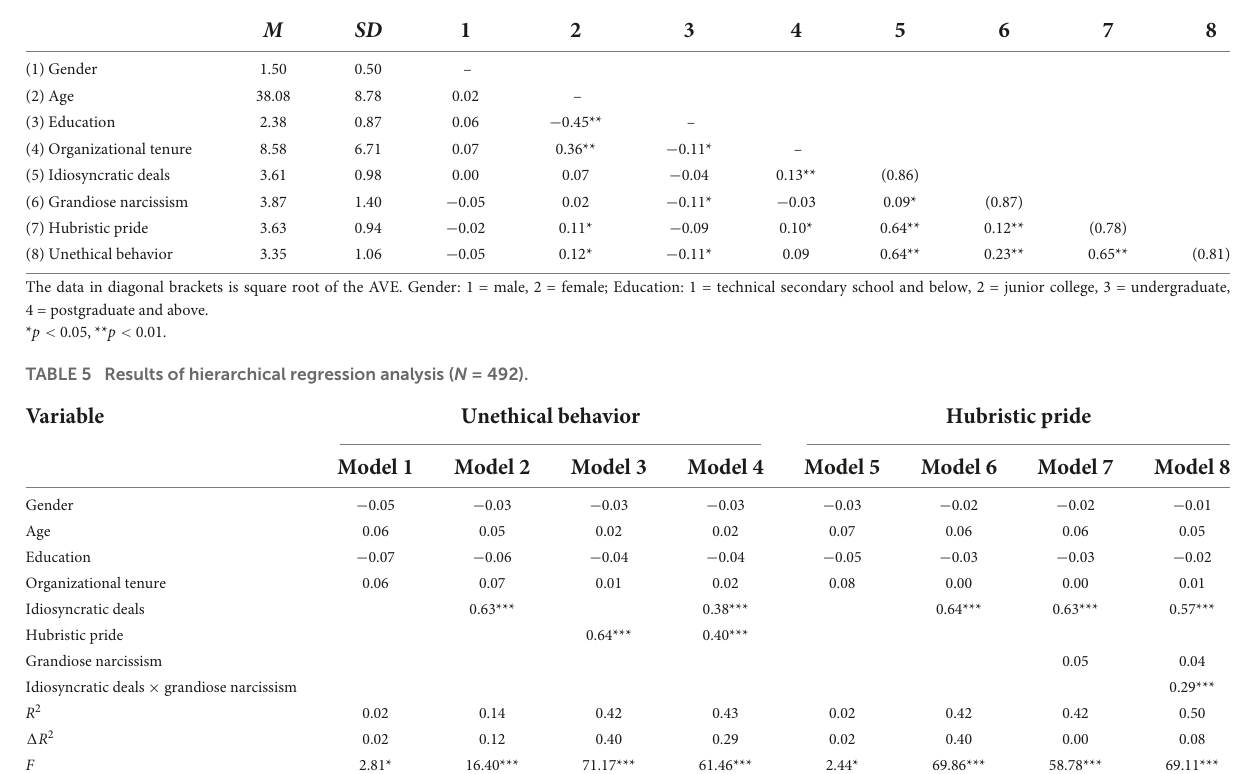
TABLE 4 Descriptive statistics and correlation analysis ( N = 492).